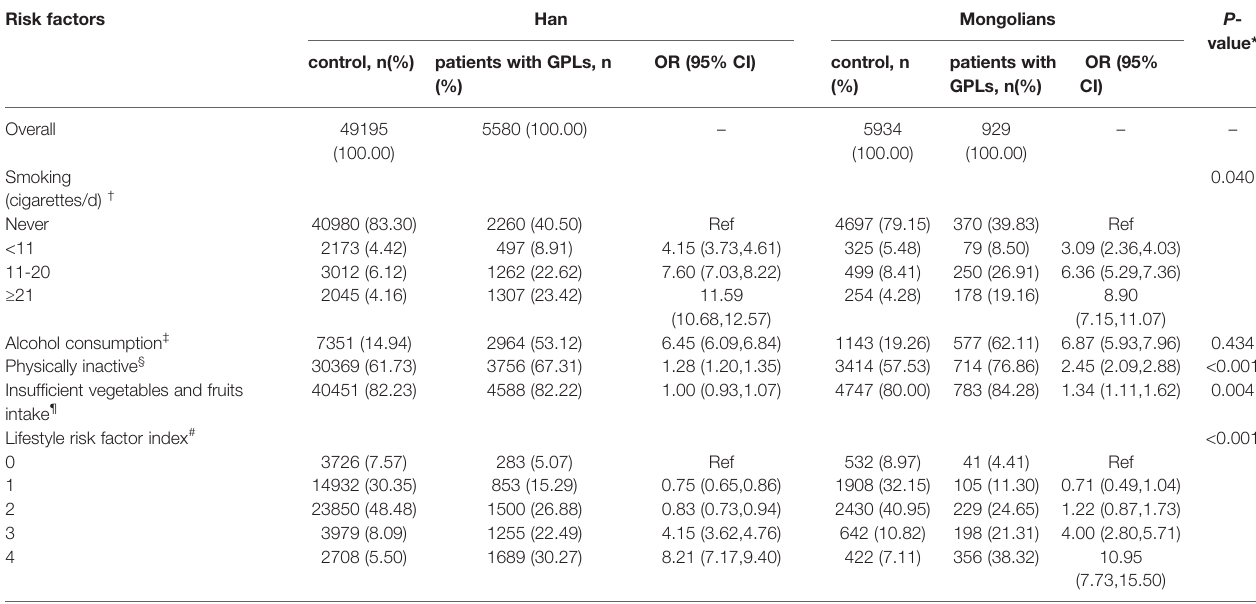
TABLE 2 | Univariate analysis of the number of behavioral risk factors for GPLs by ethnic group. Risk